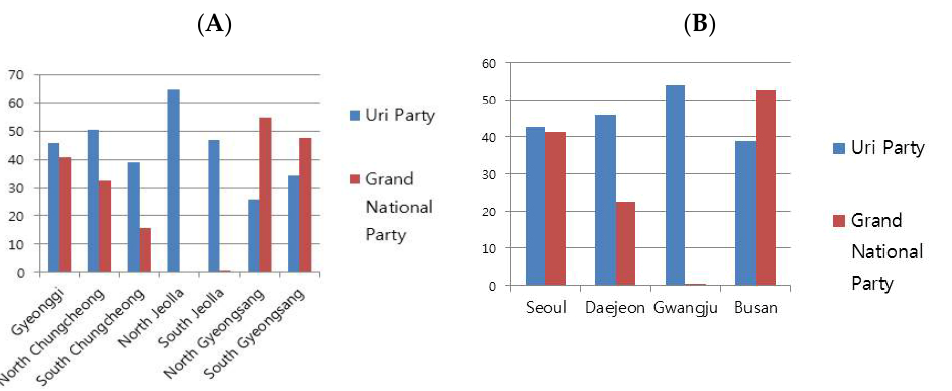
Figure 2. Voting Shares in the Seventeenth General Election of 2004. ( A ) Voting Shares by Province. ( B ) Voting Shares by Urban/Rural Division.